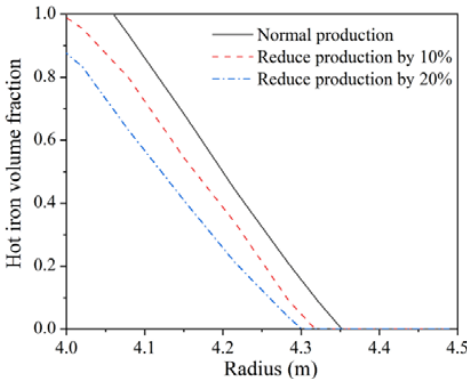
Figure 12. The volume fraction of hot iron on the evaluation line after production reduction.